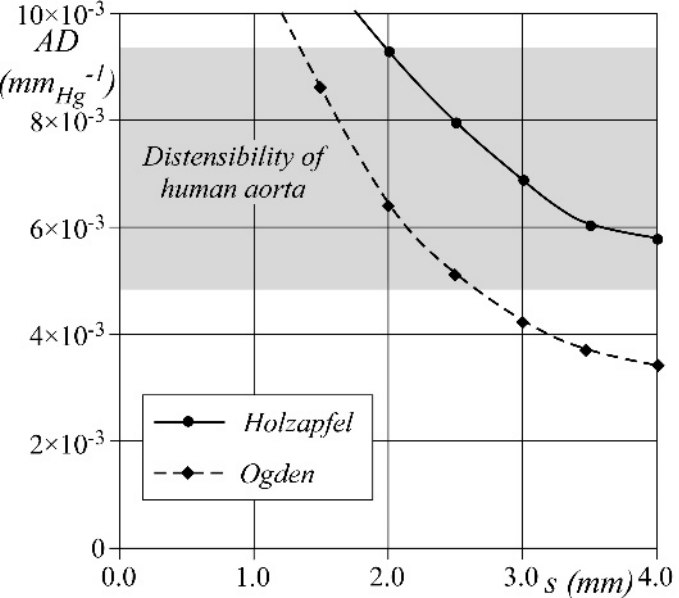
Figure 5. Comparison of numerical aortic distensibility between the two constitutive models; black diamonds and black circle are computed 𝐴𝐷 , respectively, for the Ogden (silicone) and Holzapfel (porcine tissue). Grey area shows the range of in vivo human 𝐴𝐷 measured in young healthy patients [20].